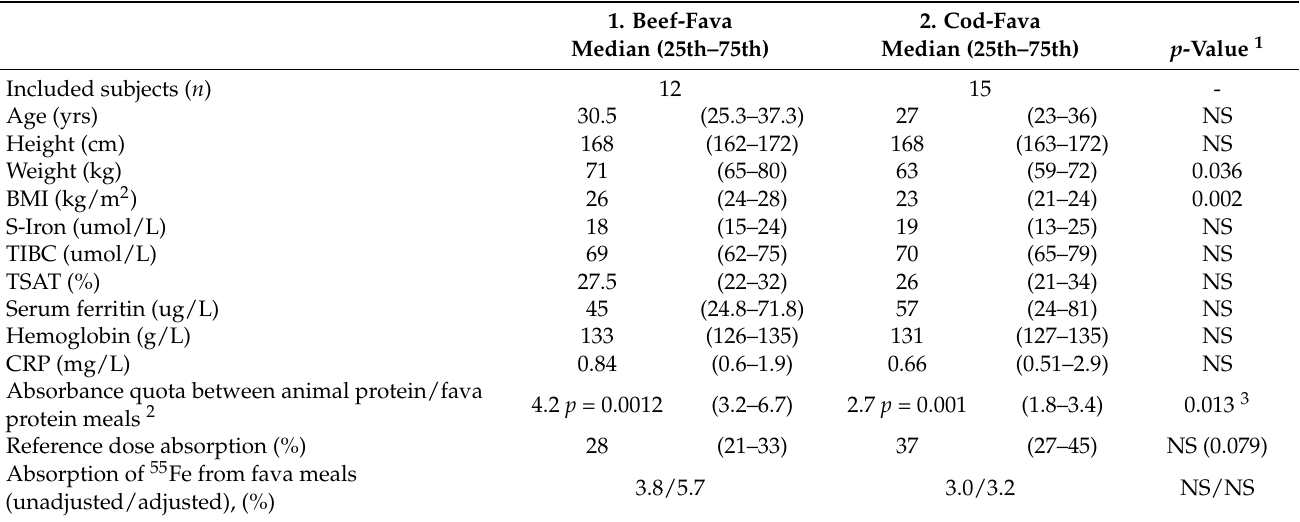
Table 3. Subject data for Study Group 1 (beef–fava) and Study Group 2